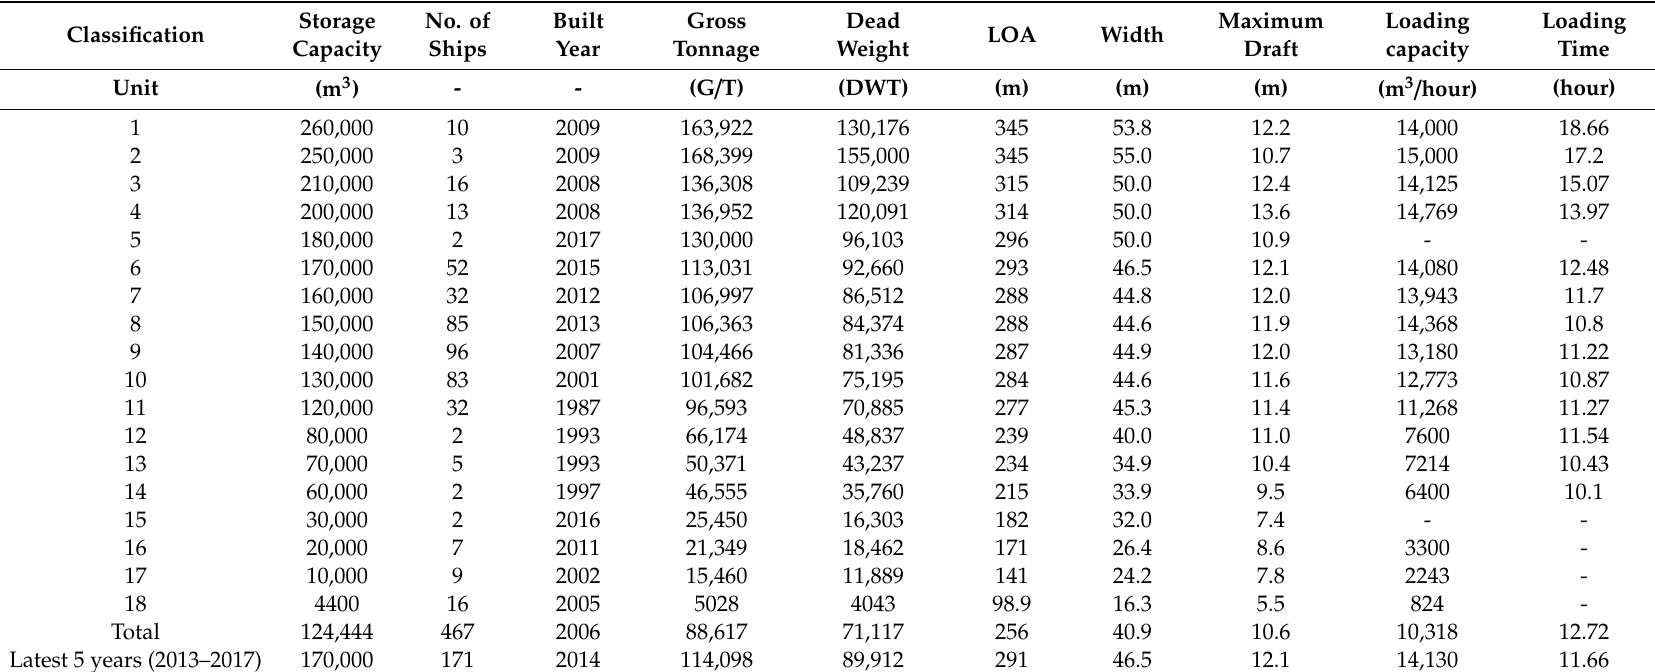
Table A3. Analysis of LNG Carriers and Bunker Shuttles Worldwide (Analysis by November